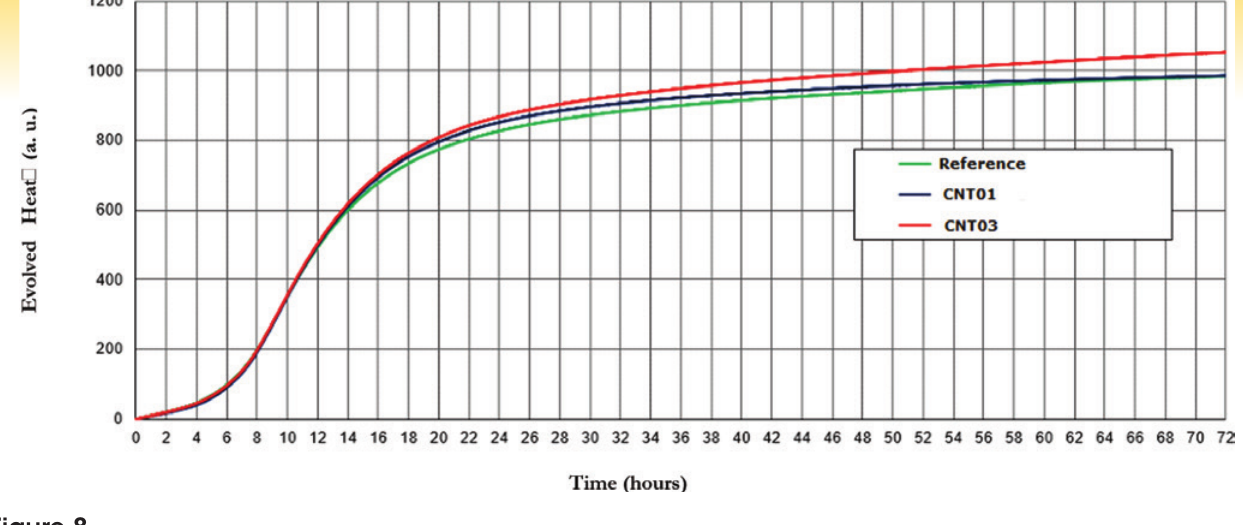
Evolved accumulated heat (a. u.) of the cement pastes